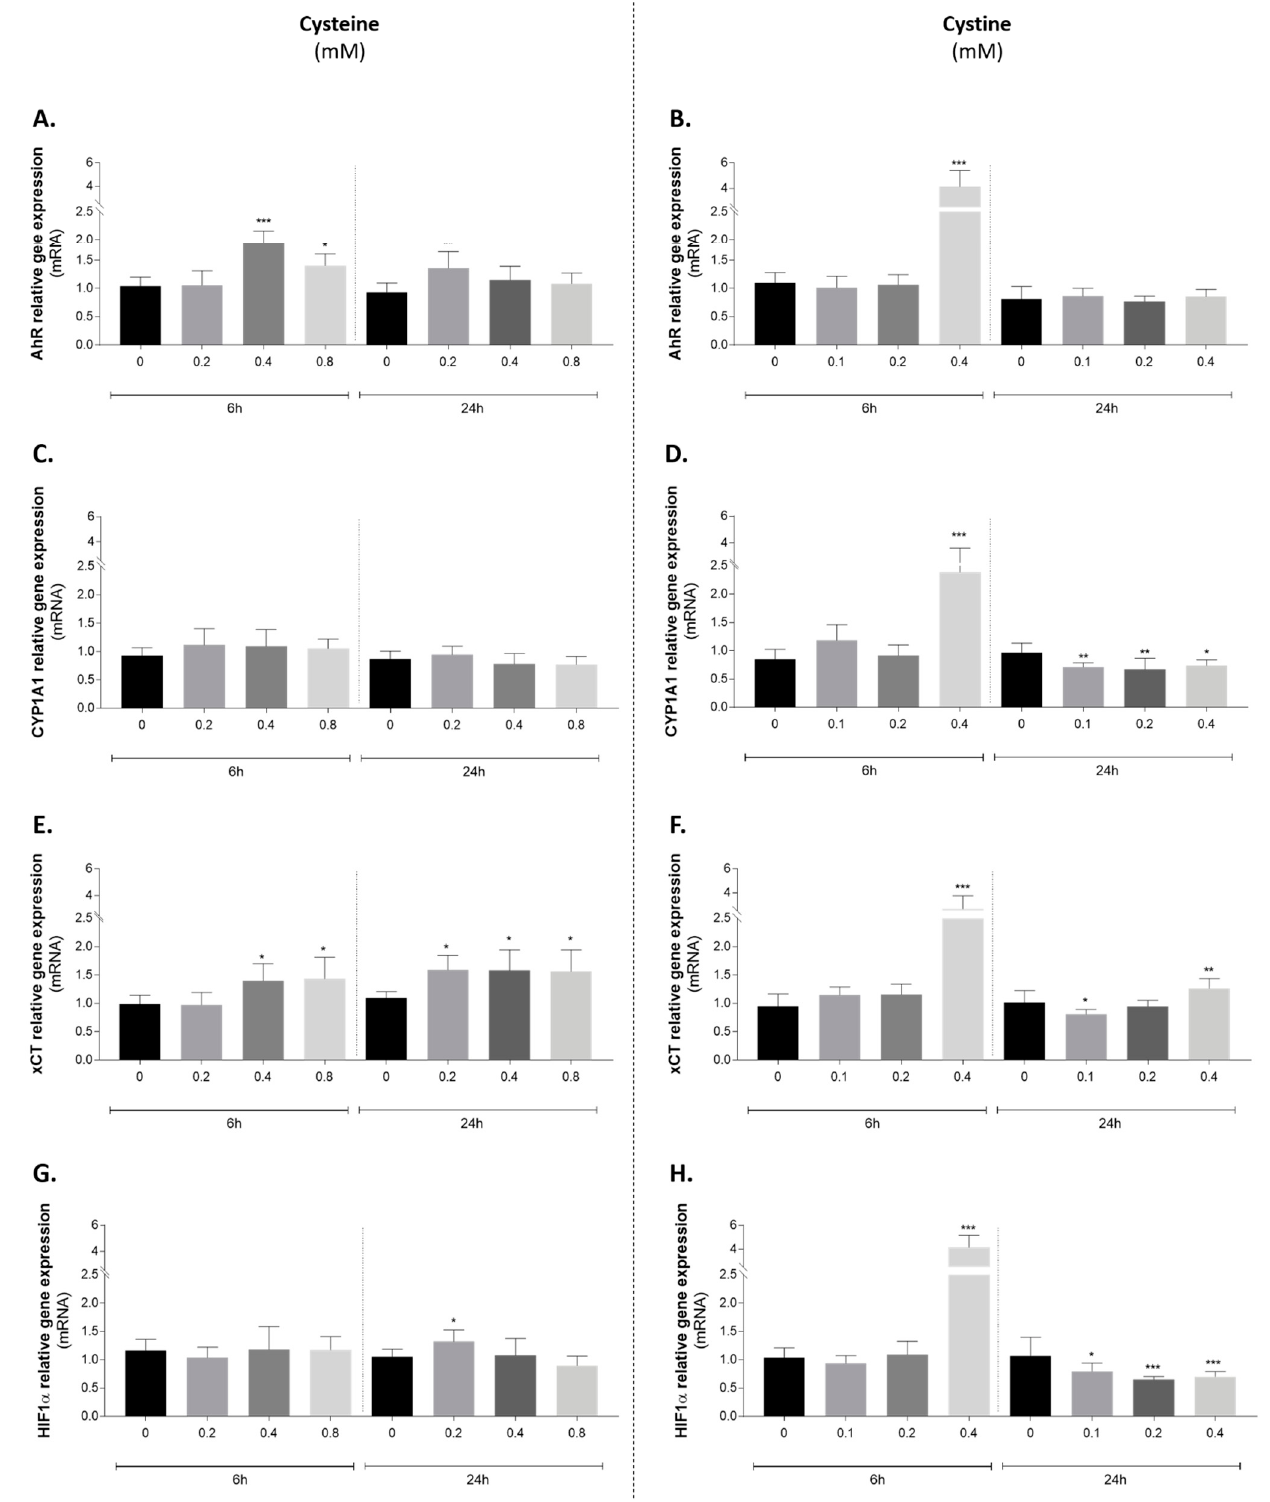
Figure 7. Effect of cysteine (left panel) and cystine (right panel) administration to endothelial cells on the expression of ( A , B ) Ahr ; ( C , D ) Cyp1a1 ; ( E , F ) xCT and ( G , H ) Hif1 α . One-way ANOVA with Dunnet’s multiple comparisons test vs. control condition: * p < 0.05; ** p < 0.01; *** p < 0.001. AhR: aryl hydrocarbon receptor; Cyp1a1: cytochrome P450 family 1, subfamily A, polypeptide 1; Hif1 α : hypoxia inducible factor 1 α ; xCT: cysteine/glutamate transporter.